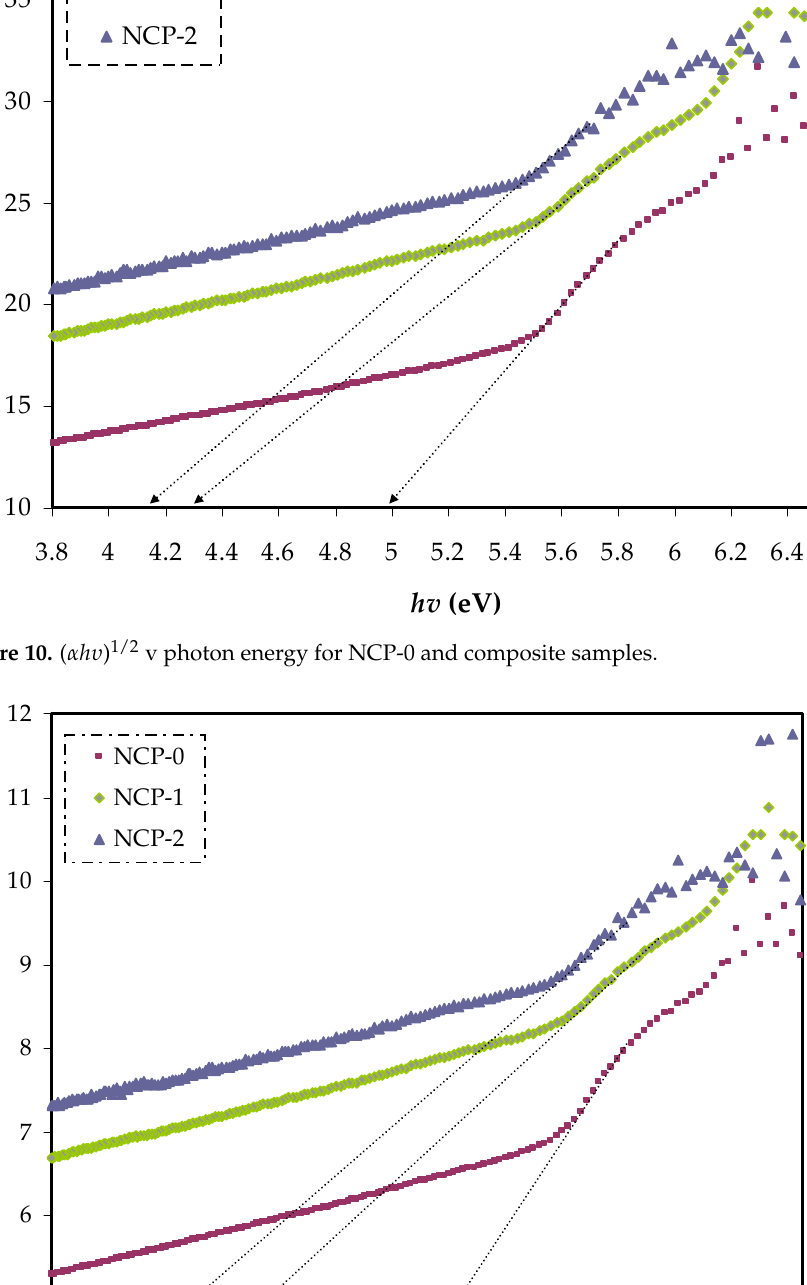
Figure 9. ( α h υ ) 2/3 v photon energy for NCP-0 and composite samples.